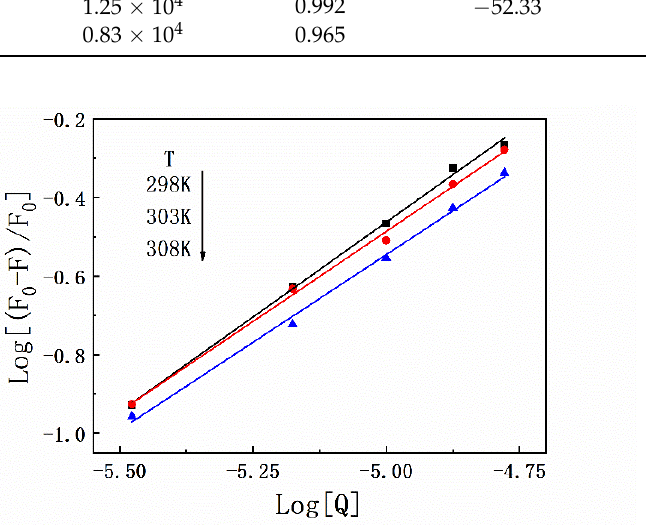
Figure 3. Plots of Log[(F0 − F)/F0] versus Log[Q] for HSA–SMT complex under different